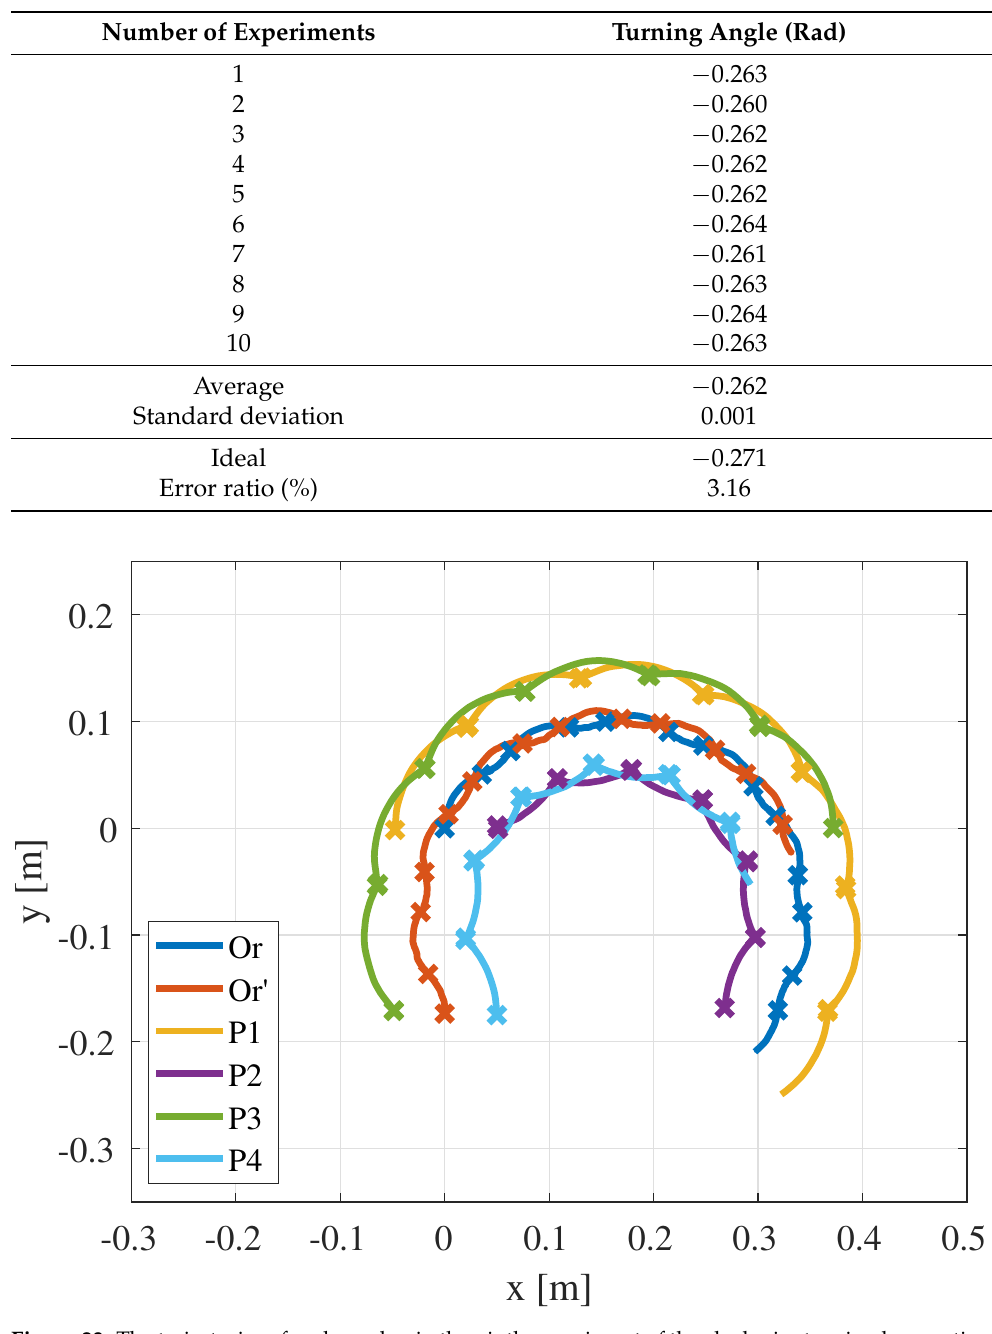
Figure 23. The trajectories of each marker in the ninth experiment of the clockwise turning locomotion experiment. The “ × ” marks represent the locations of the robot coordinate with respect to each half period of the input angle function. The relative angles of the “ × ” marks (colored in blue) are the turning angles of the